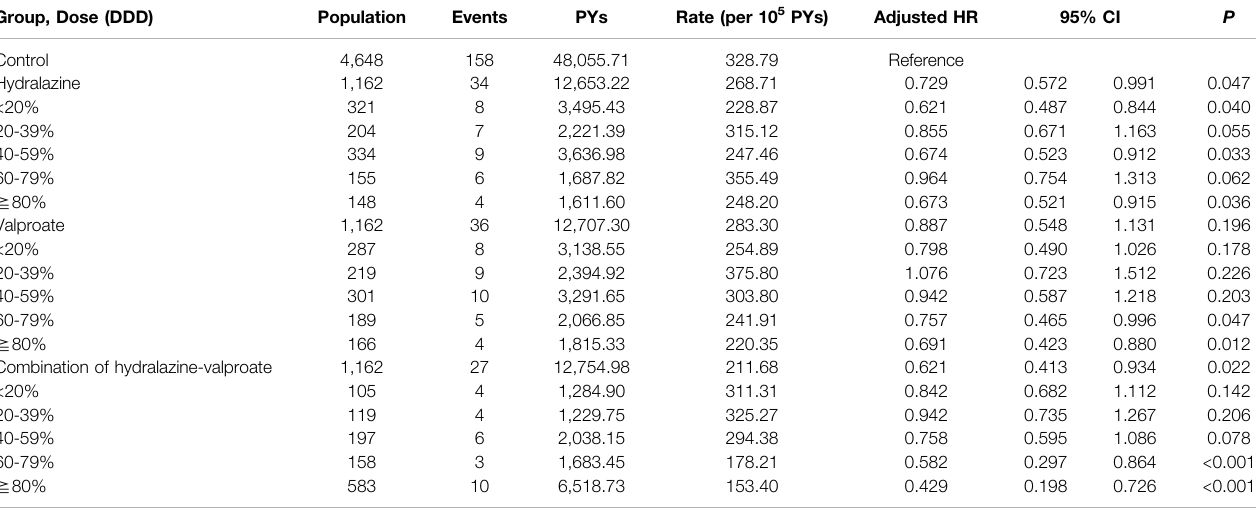
PYs, Person-years. Adjusted HR, adjusted hazard ratio, adjusted by the variates listed in Table 1